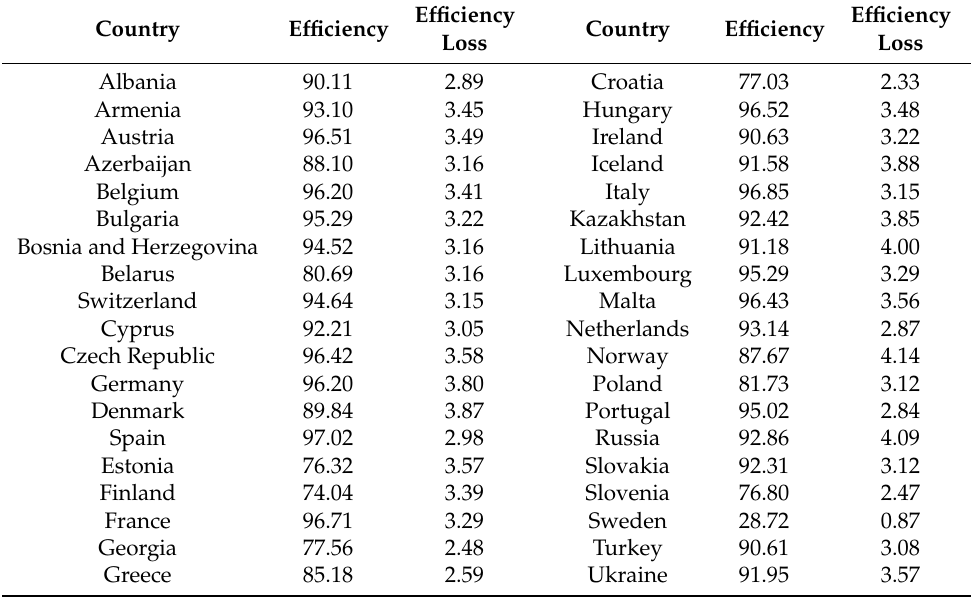
Table 3. Average Efficiency Estimates and Effects of